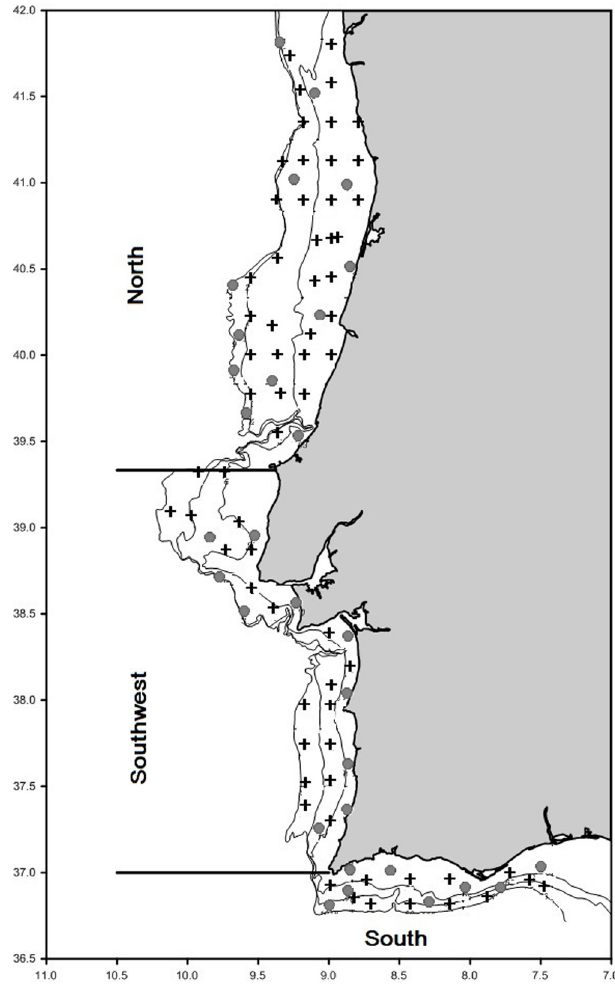
Fig. 1. Portuguese continental margin showing the sampling stations for bottom trawl surveys conducted between 1990 and 2011, where blue whiting was sampled, and 100 m, 200 m and 500m isobaths. þ Fixed stations; ● random